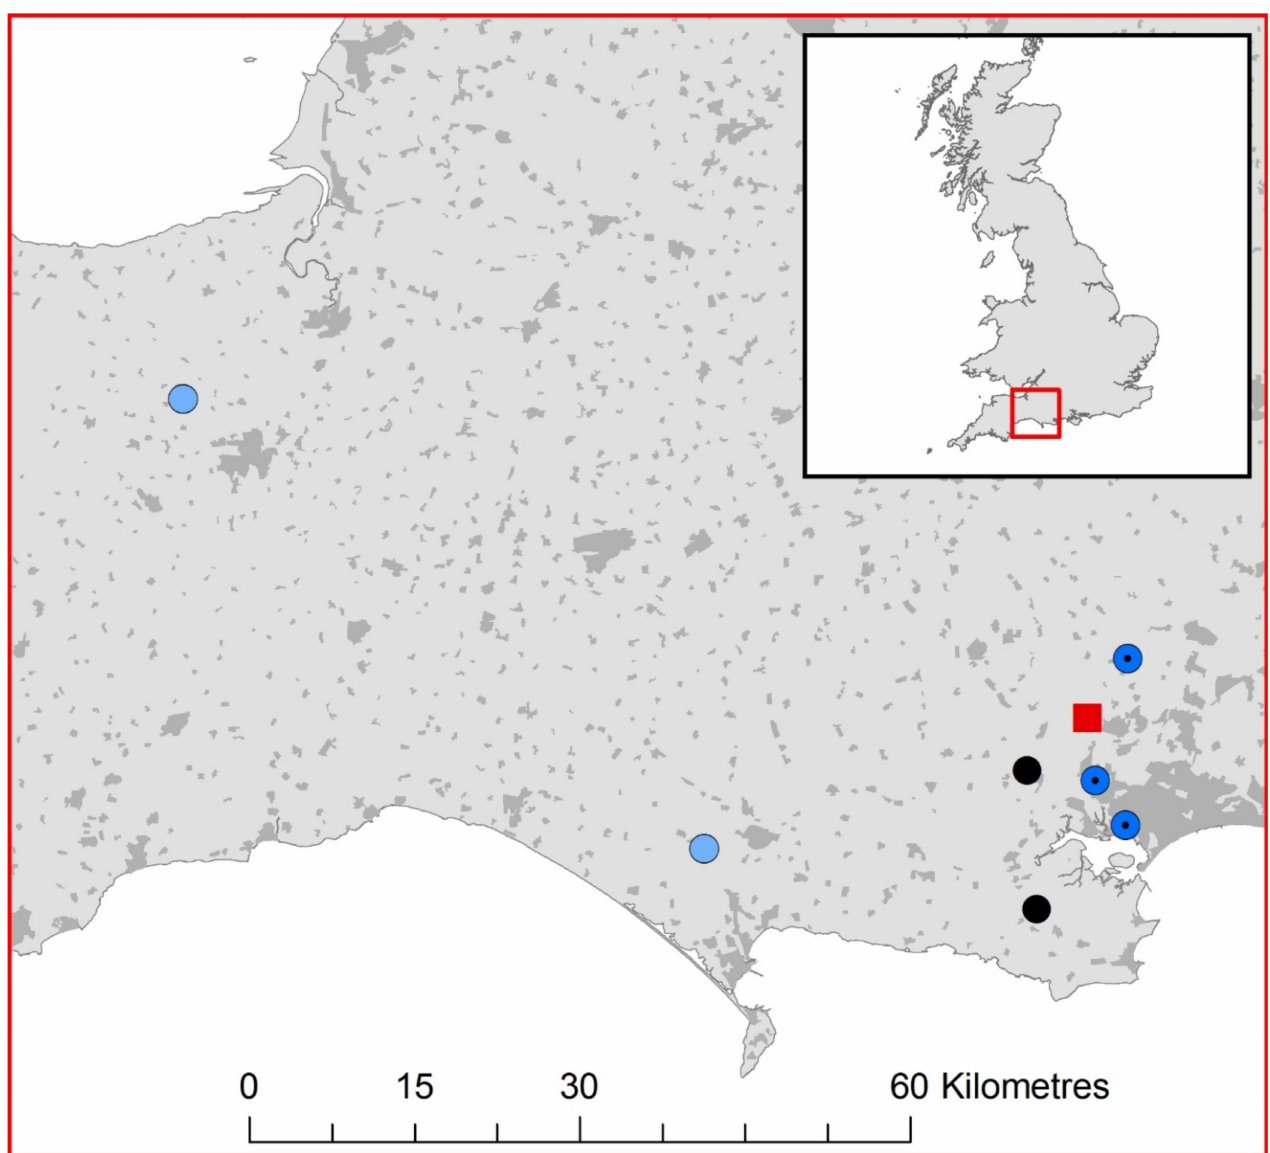
Figure 1. Location of the seven EBLV-1 positive serotine bats ( E. serotinus ) (black circles =2018, filled dark blue circles = 2019, and open light blue circles = 2020) and one lyssavirus FAT positive soprano pipistrelle ( P. pygmaeus ) (red square) in England. The base map highlights urban areas in dark